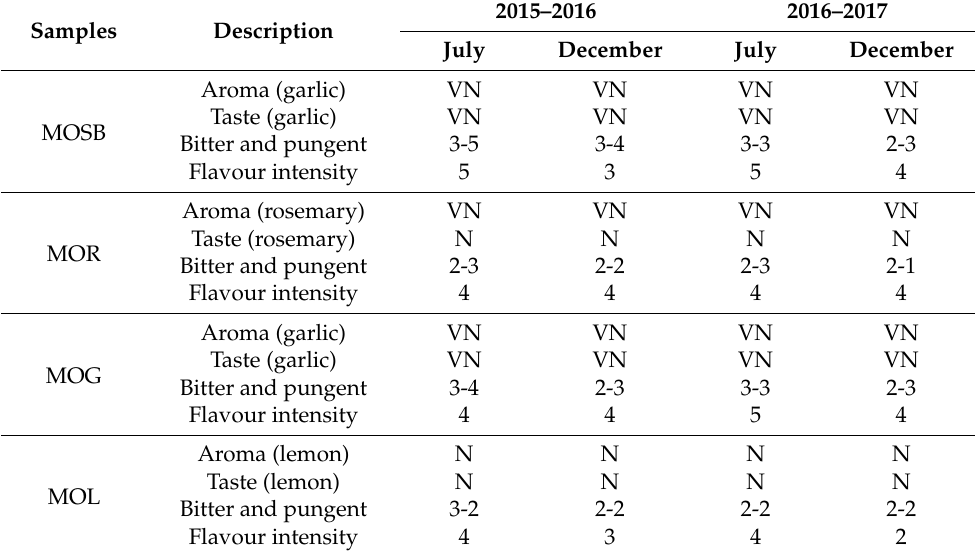
Table 4. Sensorial profile of the flavoured oils.